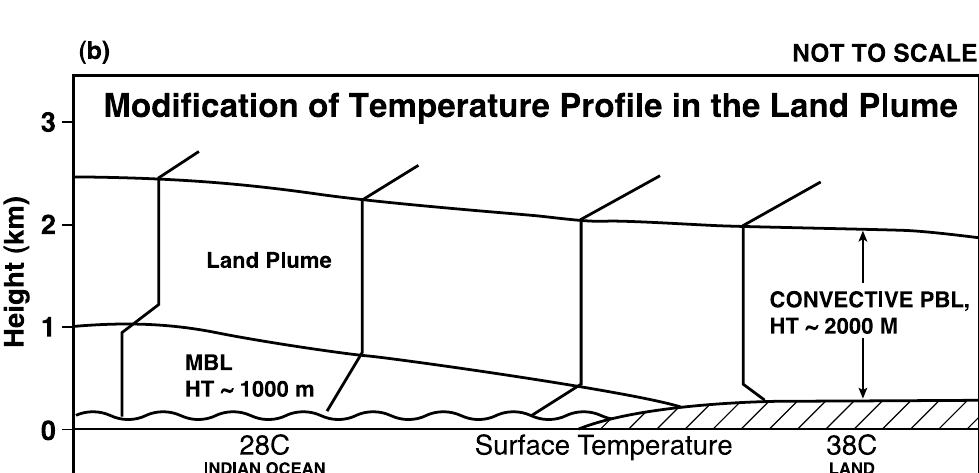
taken from the published literature use the equivalent